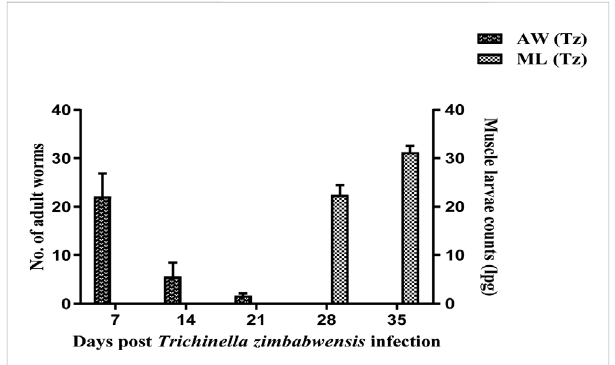
FIGURE 2 Mean number (± SD) of intestinal adult worms and muscle